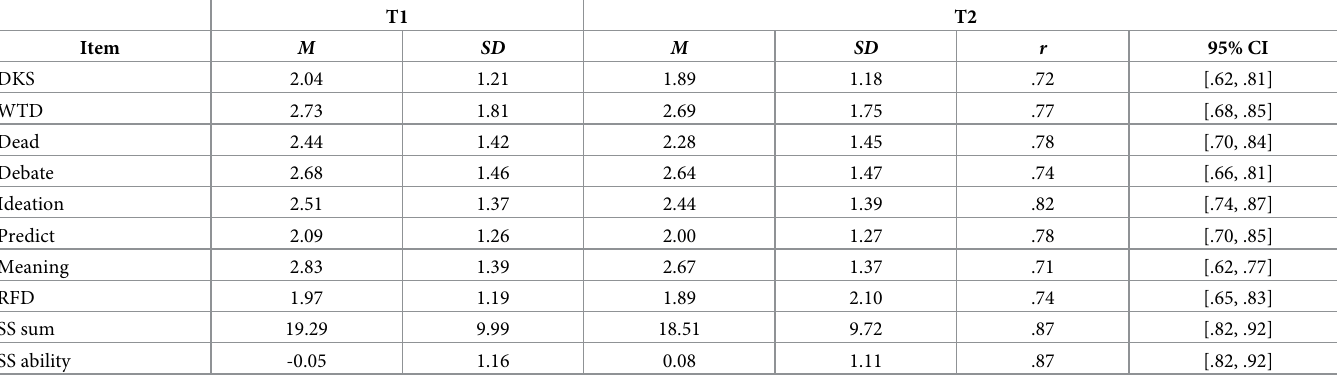
Table 5. Suicidality Scale time 1 and 2 (two weeks) central tendency and partial correlations.